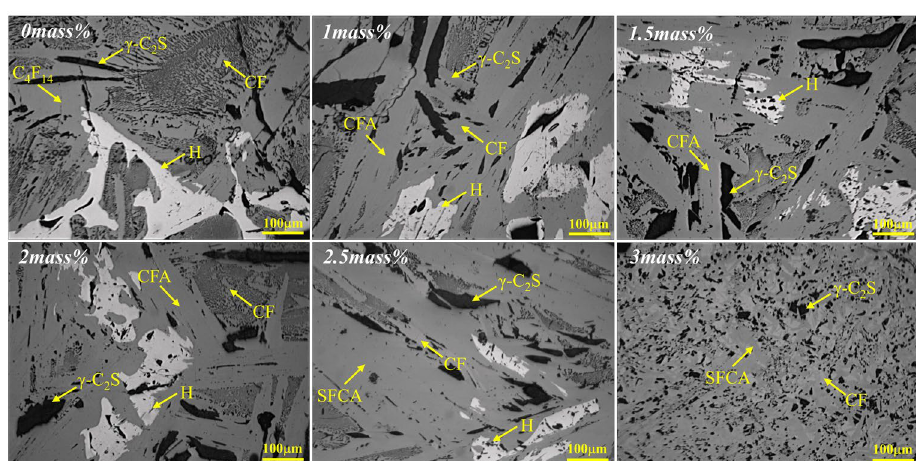
Figure 3. Optical photos of the samples cooled at 0.02 °C/s (CF: CaFe 2 O 4 ; C 4 F 14 : Ca 4 Fe 14 O 25 ; SFCA- Ι